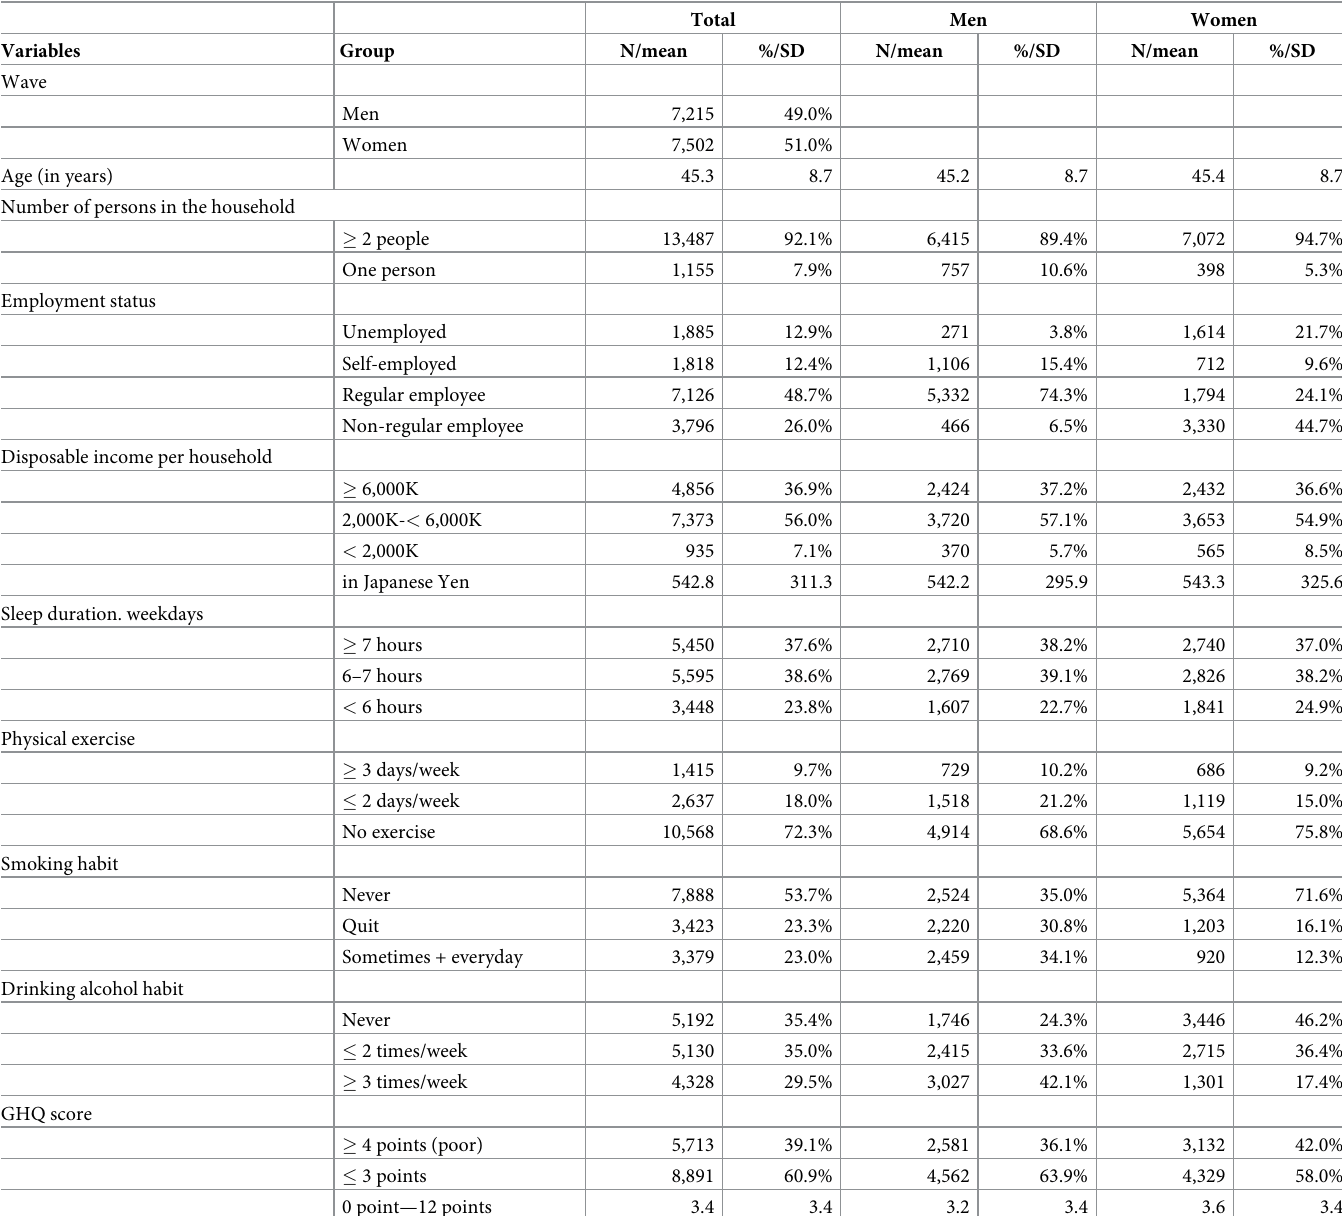
Table 2. Participants’ demographic